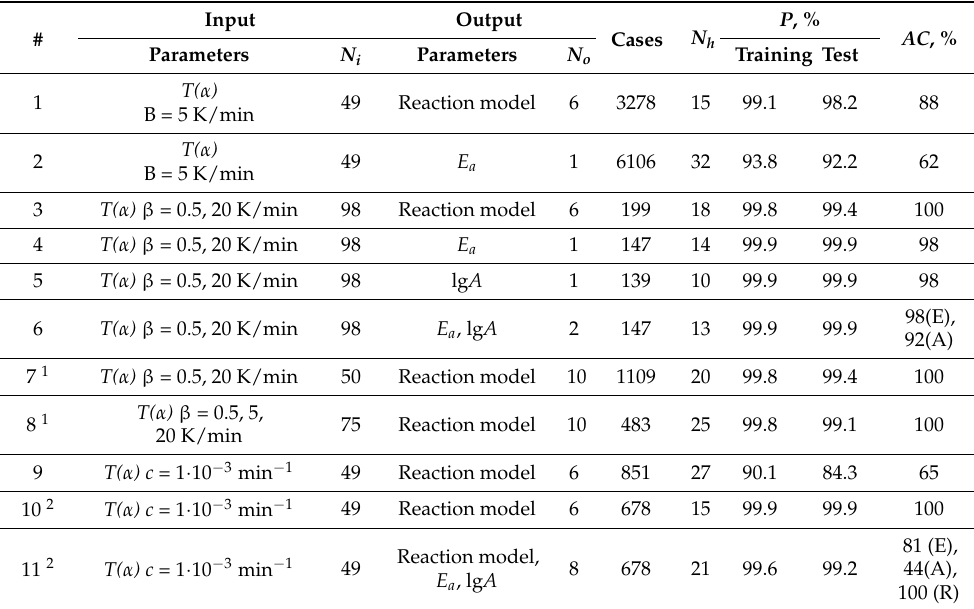
Table 4. ANN details and performance of models developed for kinetic analysis in Ref. [21]. Reprinted with permission from